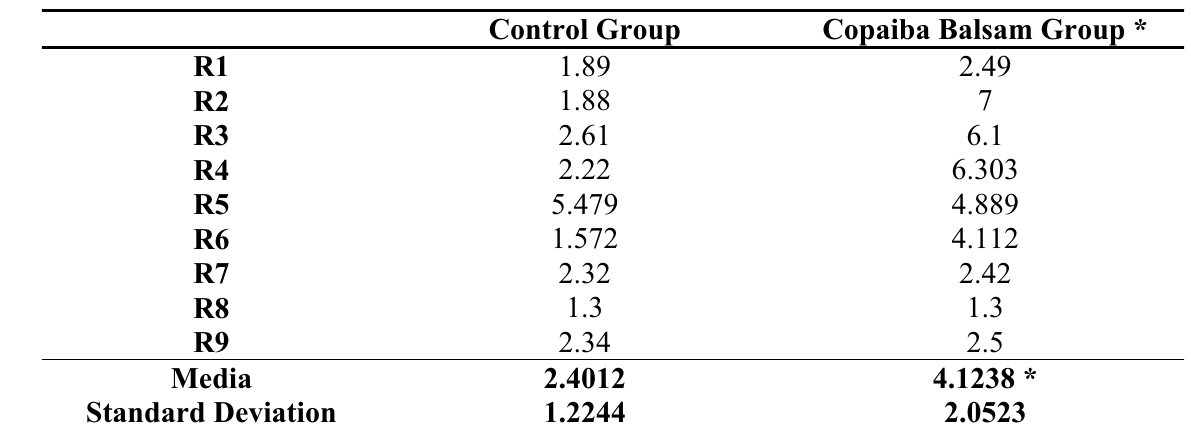
TABLE 1 – Tumoral weight of GC and Gcop, in